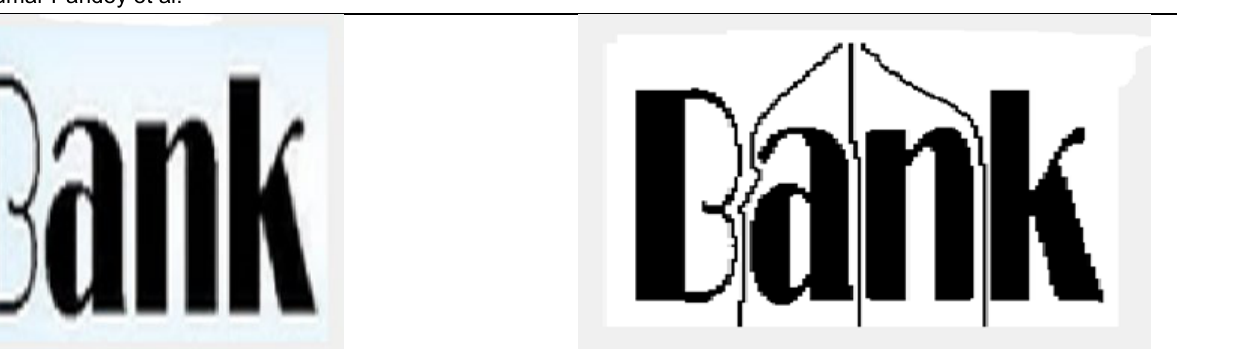
Figure 5. Textual images after applying segmentation